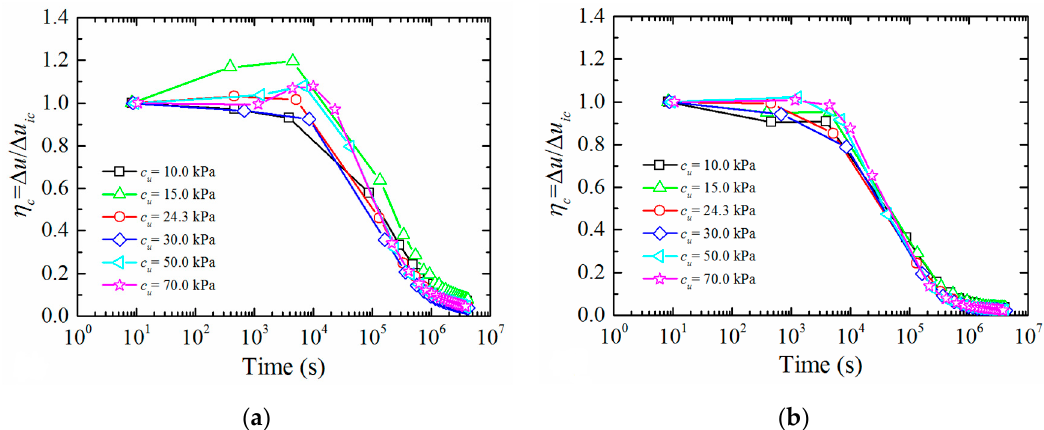
Figure 13. Normalized EPWP dissipation curves after installation under various soil undrained shear strengths. ( a ) At depth of 4.9 m; ( b ) at depth of 7.5 m.